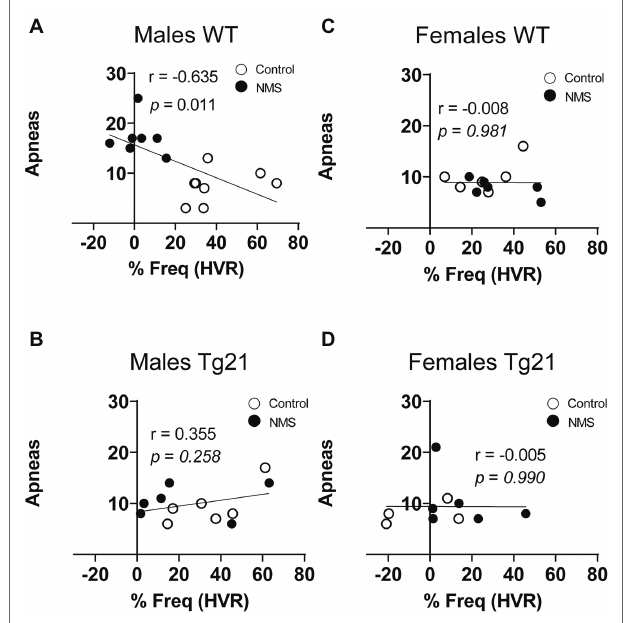
FIGURE 6 | Correlation between apneic events and hypercapnic ventilatory response (HcVR = Hc – Nx) in WT and Tg21 male (A,B) and female (C,D) mice previously exposed (or not – control) to NMS.